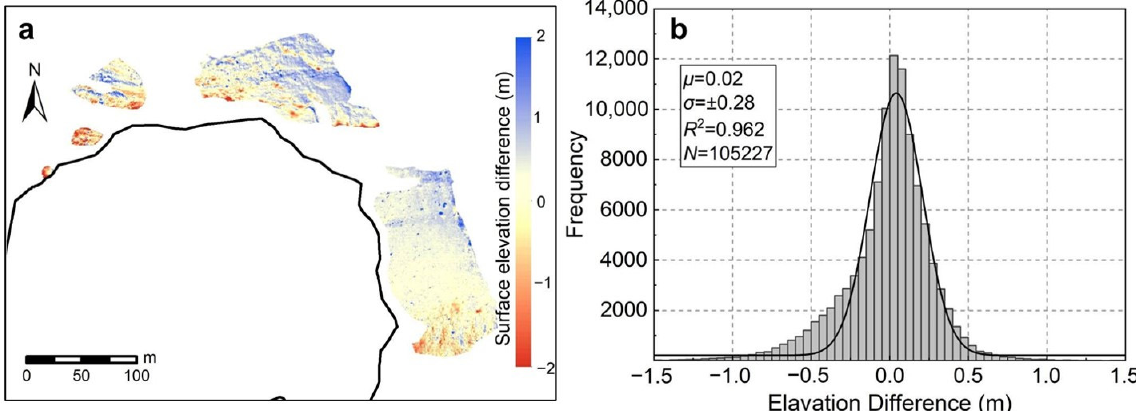
Figure 6. Spatial distribution of glacier elevation changes over stable off-glacier areas ( a ) and frequency distributions ( b ). The mean ( µ ), standard deviation ( σ ), fitting coefficient ( R 2 ), and number of pixels ( N ) are listed.